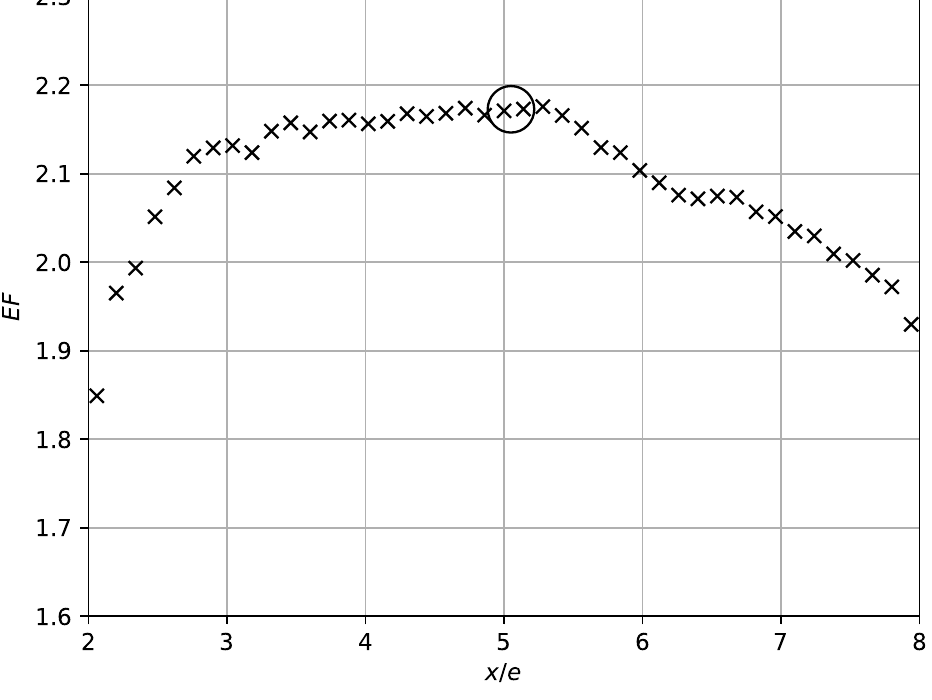
Figure 12. Display of the Nusselt number in the range from x / e = 2 to x / e = 8 to show the influence of the reattachment point of the flow on the Nusselt